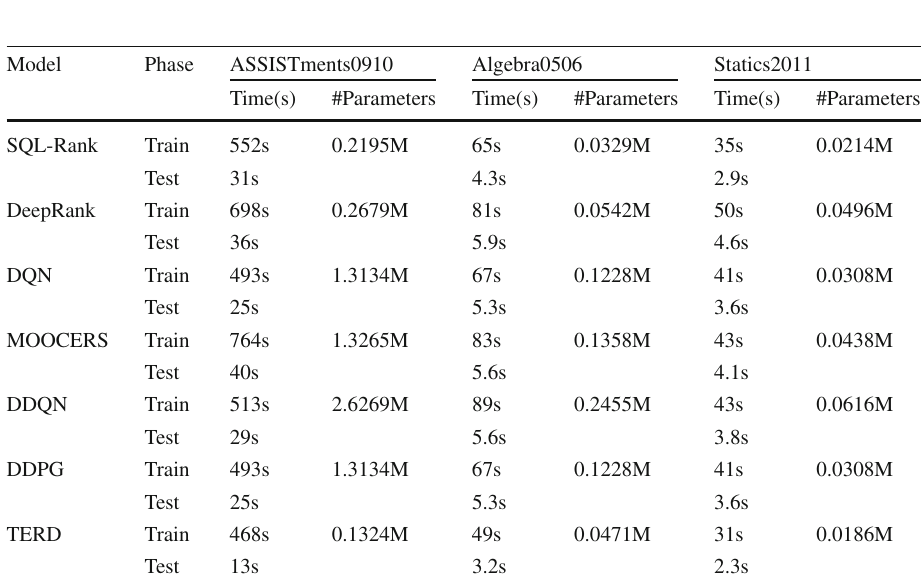
Table 7 Comparisons of efficiency on three